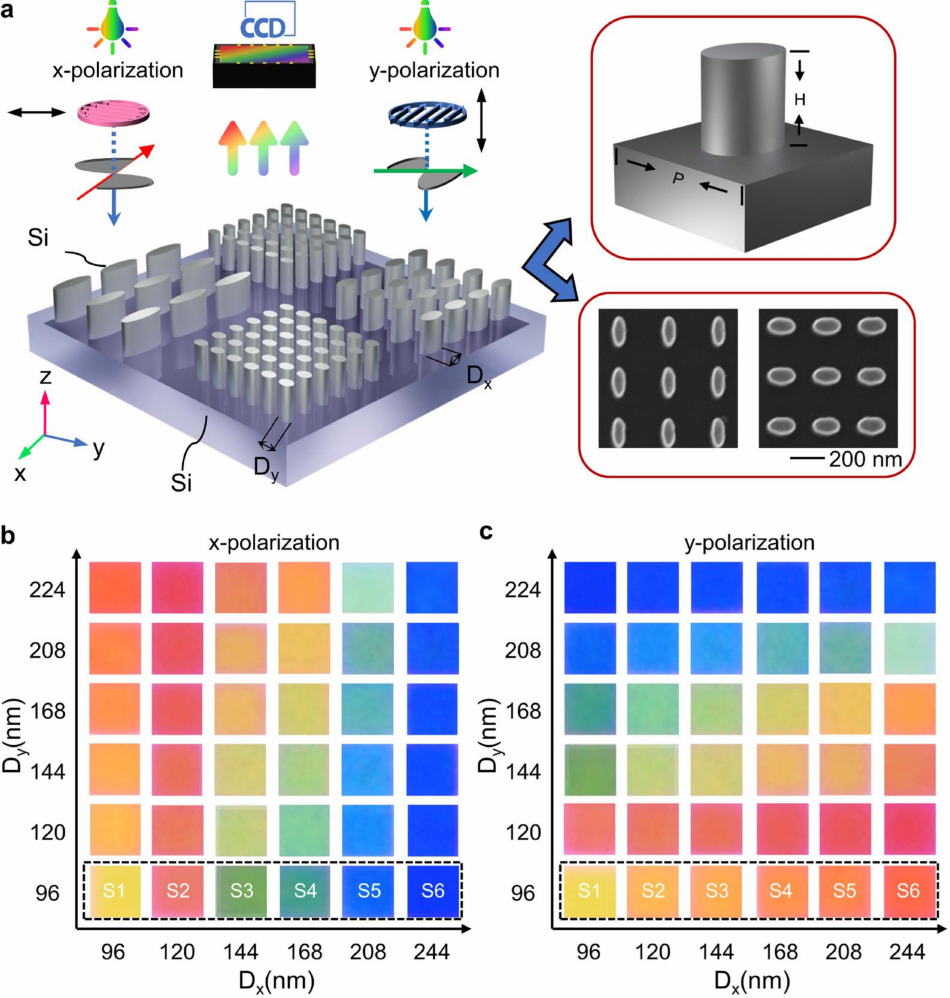
Figure 1. ( a ) Schematic of Si-based metasurfaces with periodic Si elliptical nanopillars on Si substrate. Two top-view SEM images of a typical elliptic Si nanopillar array. Optical bright microscopy image of the color palette under ( b ) x-polarization and ( c ) y-polarization